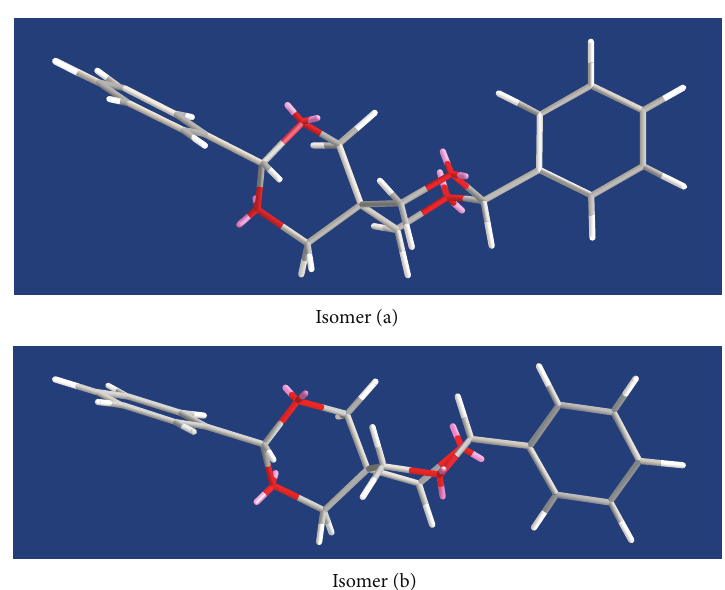
Figure 8: The steady conformations of isomers (a) and